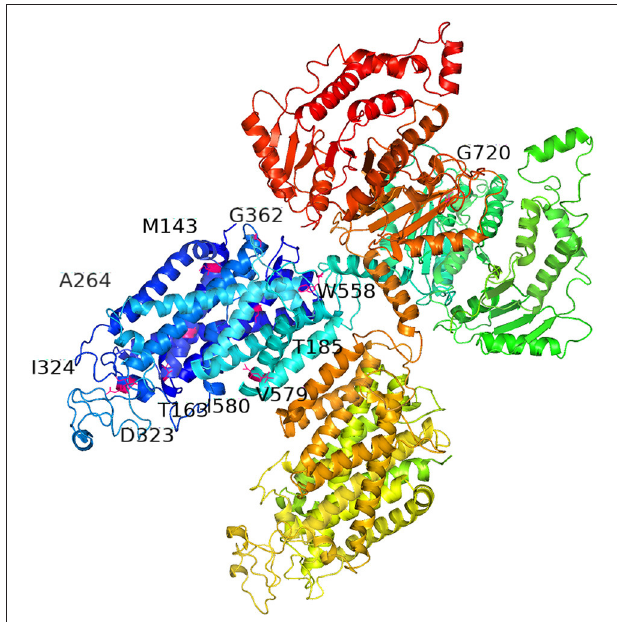
FIGURE 2 | Three-dimensional model of sodium chloride cotransporter (NCCT) showing the locations of the 11 novel SLC12A3 mutations, including missense, non-sense, deletion, and frameshift mutations, which resulted in the following amino acid variations: p.D323E, p.G362S, p.M143I, p.M143Ffs*10, p.W558R, p.579_580del, p.A264Gfs*47, p.T163Rfs*7, p.G720V, and p.T185Hfs*74 (hot pink), and p.I324N (light pink). These mutations are found in the amino acid permeases domain (amino acids 141–647; http://pfam.xfam. org/protein/P55017). Full protein sequences of the SLC12A3 mutations were submitted to SWISS MODEL (http://swissmodel.expasy.org/) servers. The figure was generated using Pymol